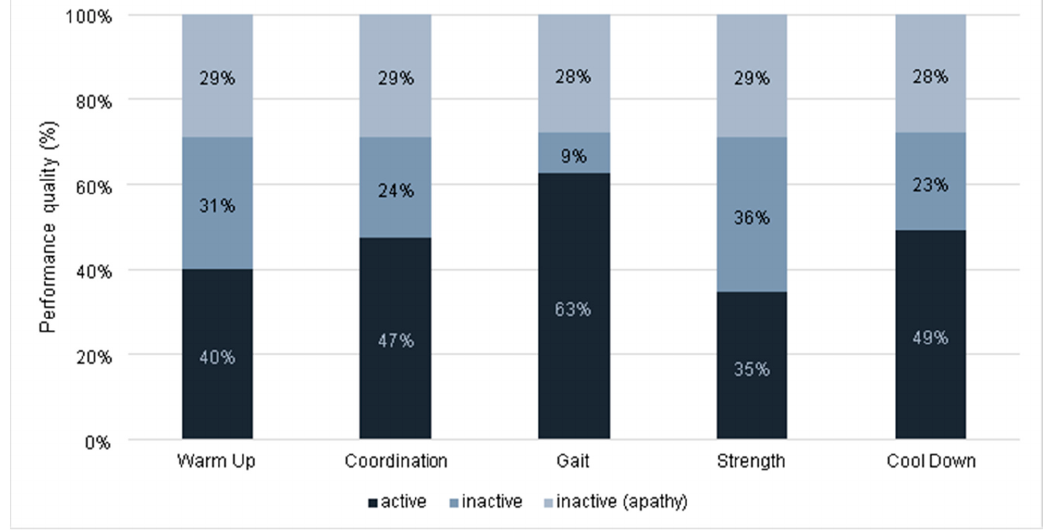
Figure 2. Performance quality (active/inactive/apathy) in percent for each component observed during eight training sessions.